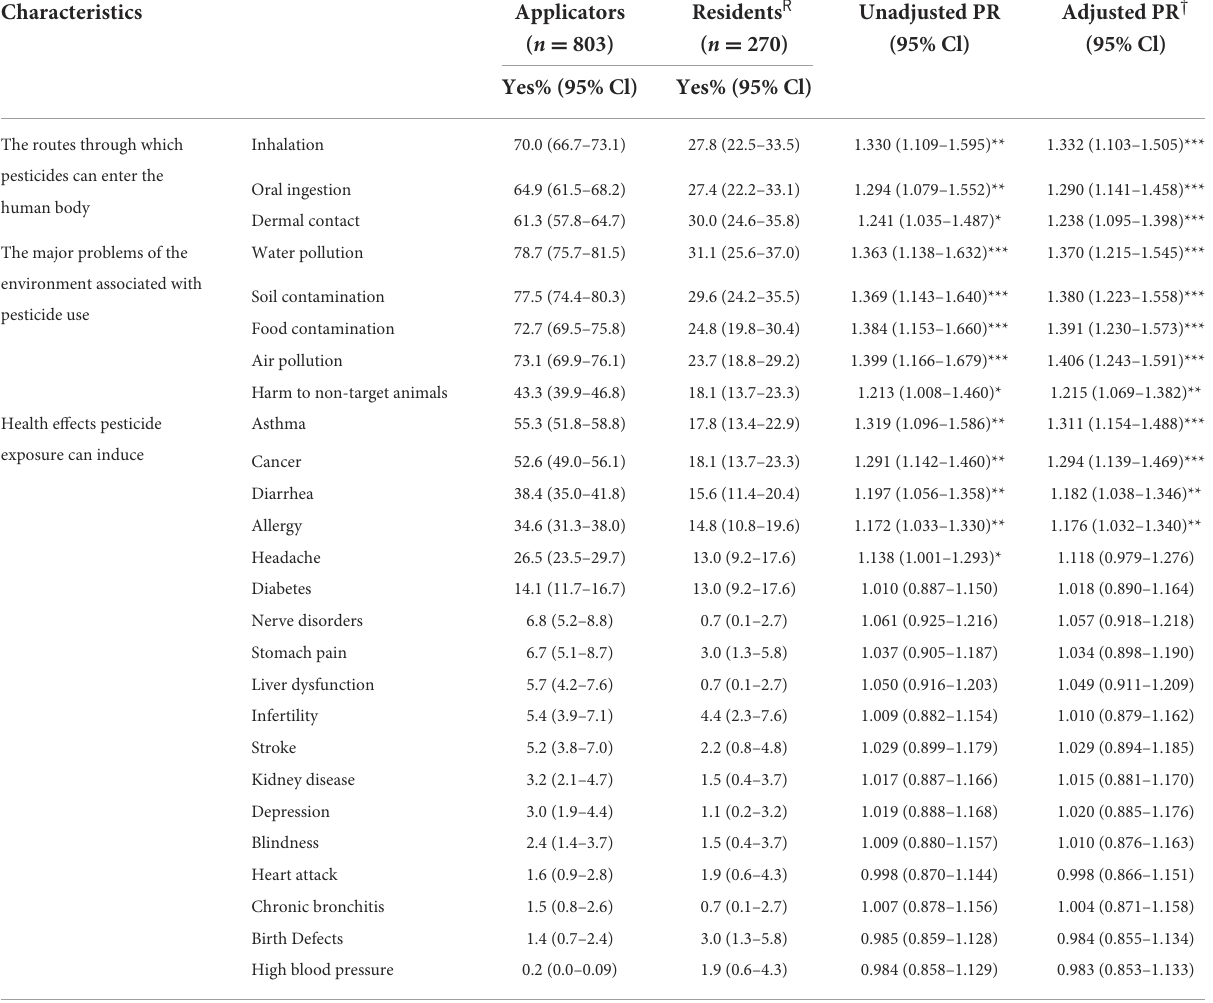
TABLE 3 Knowledge of routes of exposure, problems that pesticides pose on the environment, and health effects of pesticide exposure among pesticide applicators and residents in East Hararge Zone, Oromiya Region,